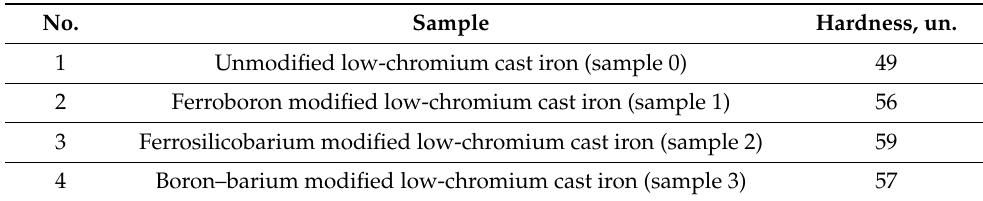
Table 3. Average values of surface hardness of low-chromium cast iron samples, HRC un. No. Hardness, un.